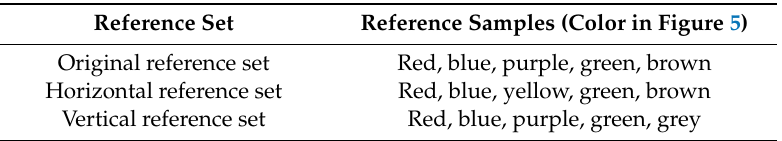
Table 2. Multiple reference sets.